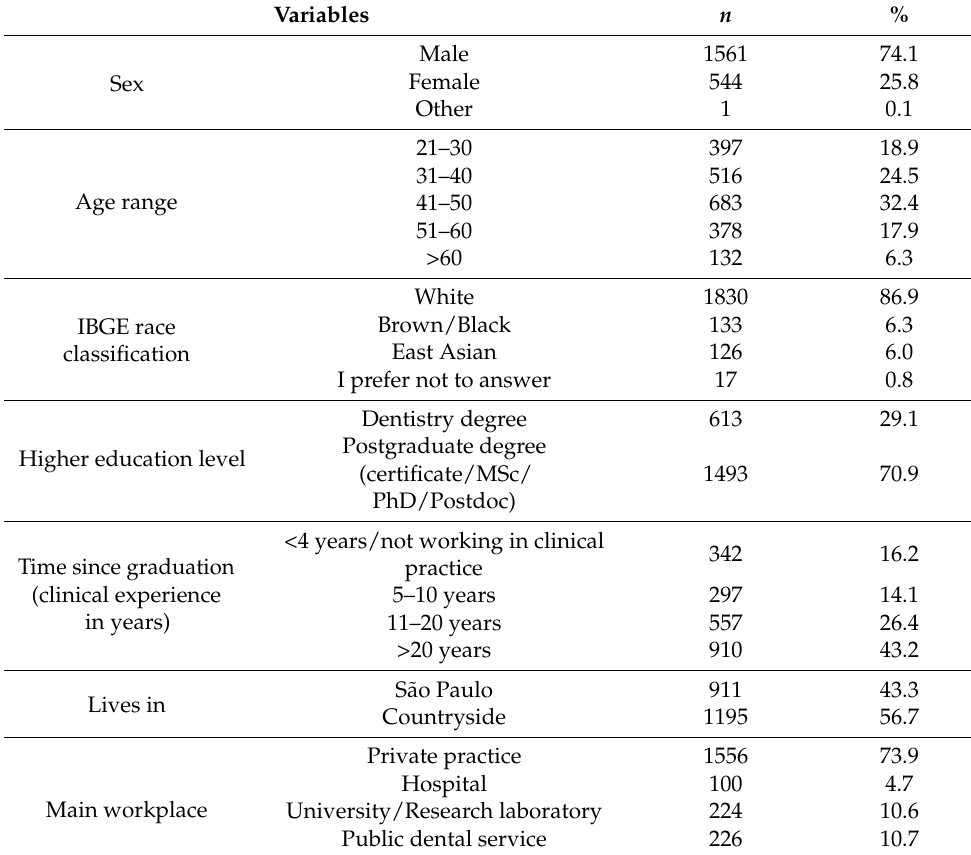
Table 1. Sociodemographic and work characteristics of the participants ( n = 2106).